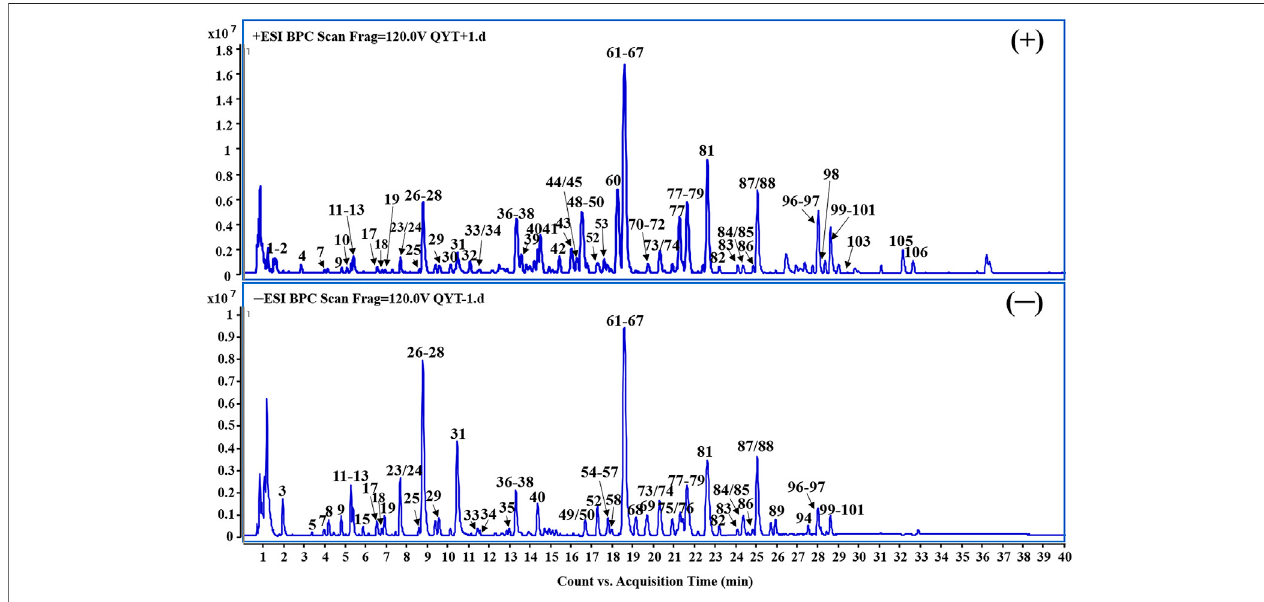
FIGURE 2 | Representative base peak chromatogram (BPC) of QYD in the positive and negative ions mode, respectively.